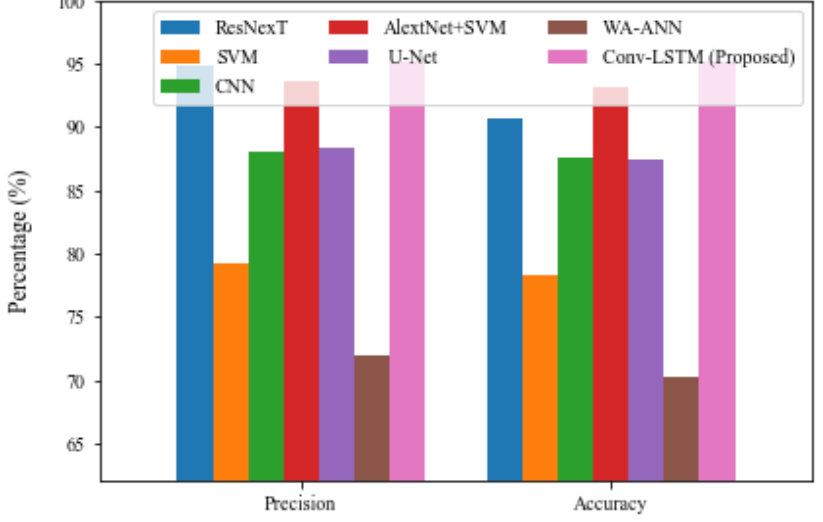
Figure 10. Comparative result analysis of Conv-LSTM with Precision and Accuracy.